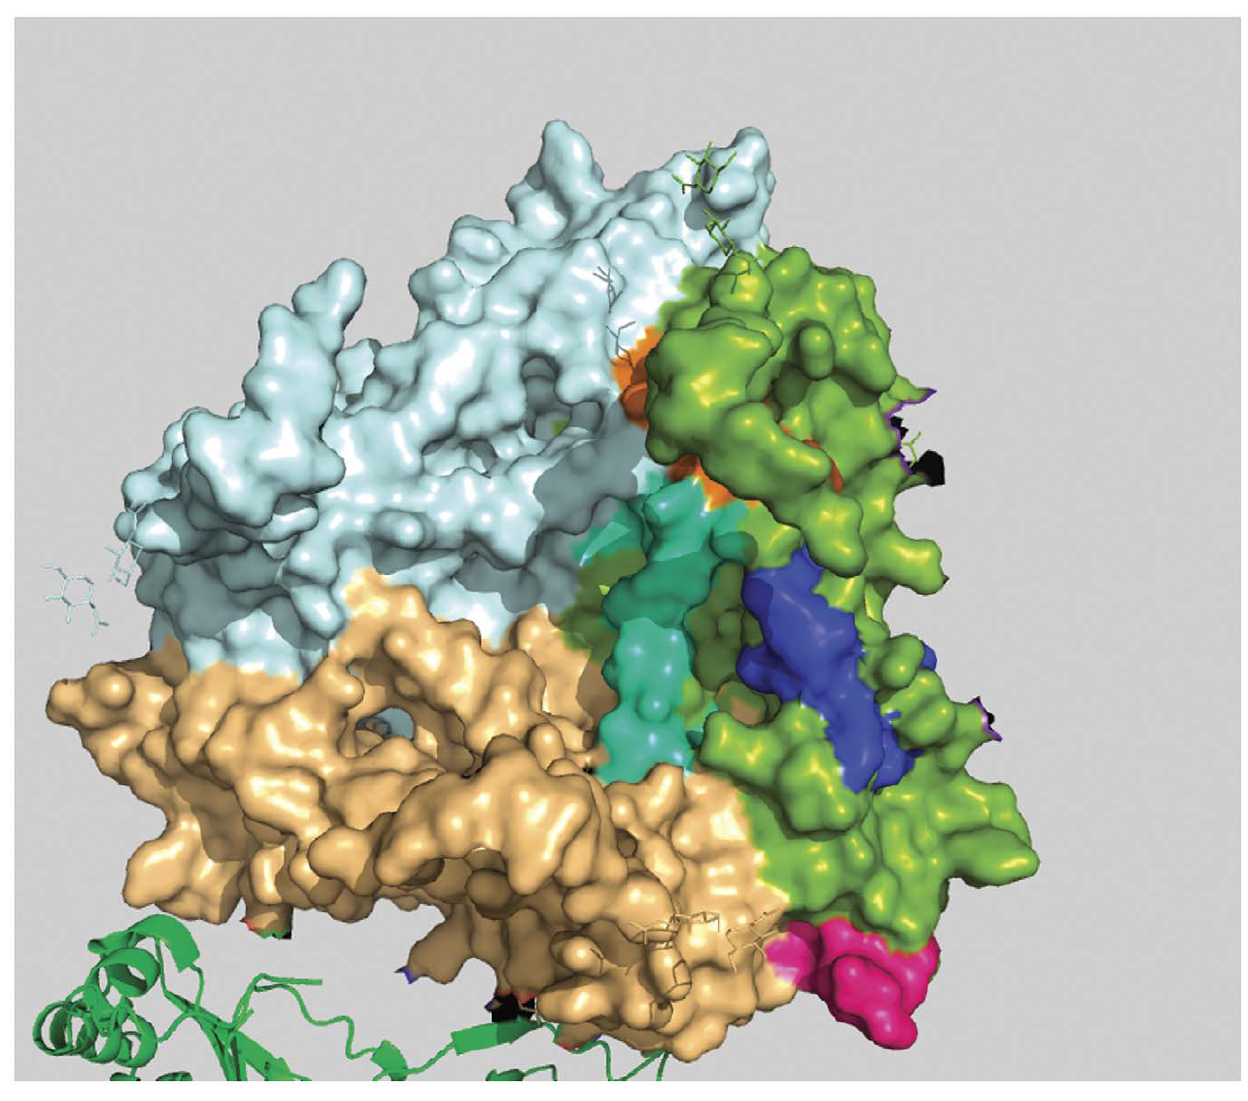
Figure 7. Position of peptide-c in a 3D space filling model of rotaviral trimeric VP7. Peptide-c (273 aa to 286 aa) is shown in cyan color and it is positioned in the green colored monomer.